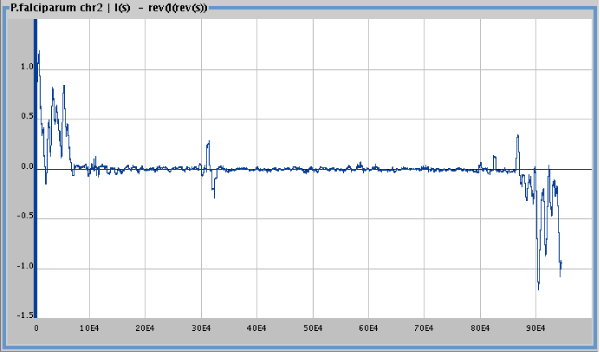
Plot of I(c2) - rev(I(revcomp(c2))) for chromosome 2 of P. falciparum, smoothing window 5000. Sequence highlighting the first and last reasonably long repeats within P. falciparum chromosome 2. The right to left information sequence is found for the reverse complement and is then reversed to be left to right. The resulting sequence is subtracted from left to right information sequence.